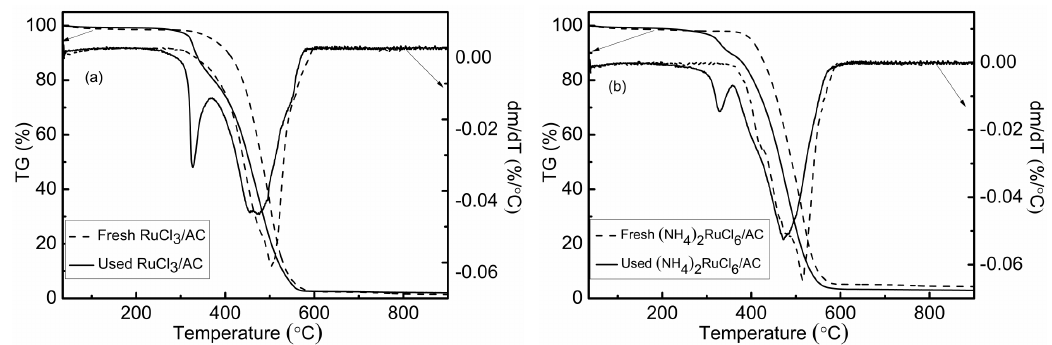
Figure 2. Thermogravimetric (TG) and derivative thermogravimetric (DTG) curves of the fresh and used 1.0 wt % Ru-based catalysts ( a ) RuCl 3 /AC; ( b ) (NH 4 ) 2 RuCl 6 /AC. Table 2. The amount of coke deposition on the used 1.0 wt % Ru-based catalysts. Catalyst